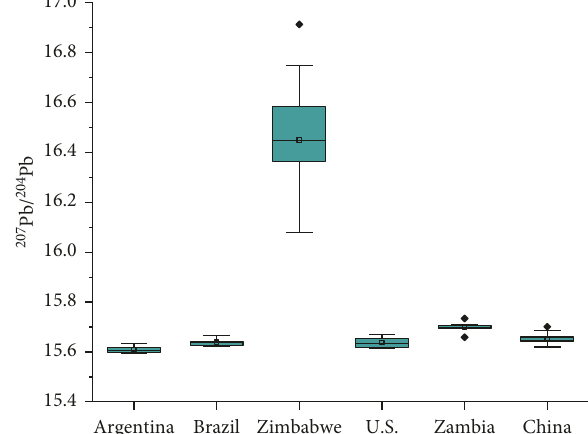
Figure 12: The box plots of 207 Pb/ 204 Pb isotope ratio.